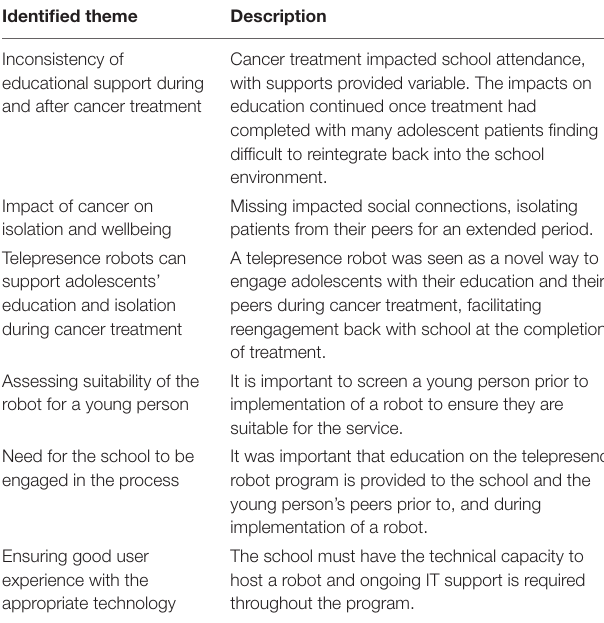
TABLE 1 | Needs assessment and ideas generation